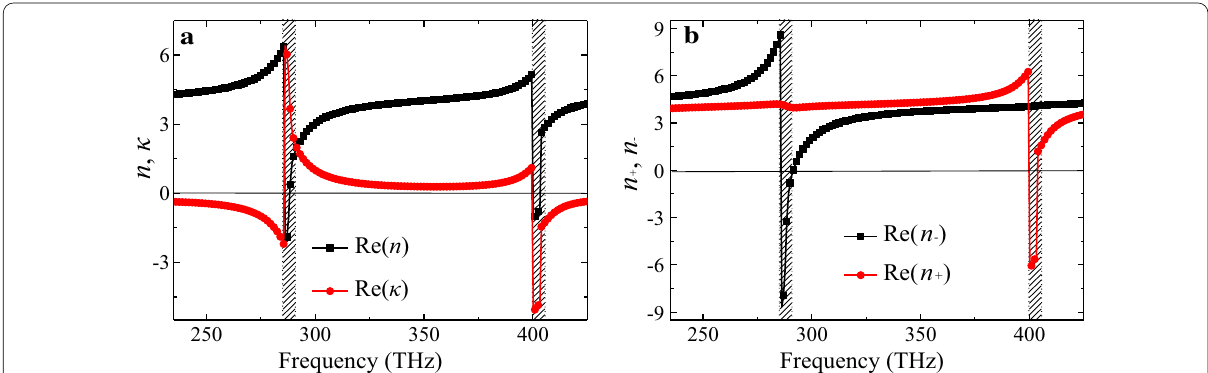
Fig. 4 The retrieved relative chiral parameters of the proposed CMSA: a real parts of average refractive index Re( n ) and chiral parameter Re( κ ), b refractive index Re( n ), Re( n ) for LCP and RCP lights − +